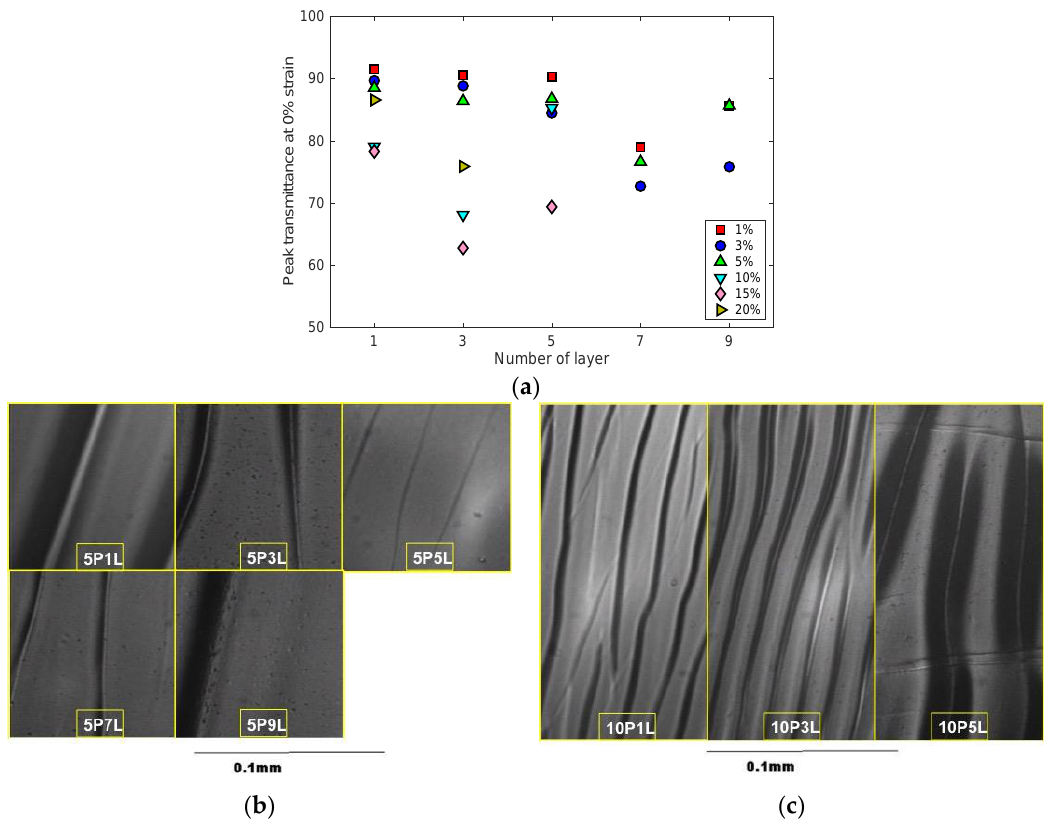
Figure 7. ( a ) Peak transmittances at 0% strain are shown with the number of PEDOT:PSS layers. Optical microscopic images are shown for the corrugated thin films that were fabricated at ( b ) 5% pre-strain and ( c ) 10% pre-strain.